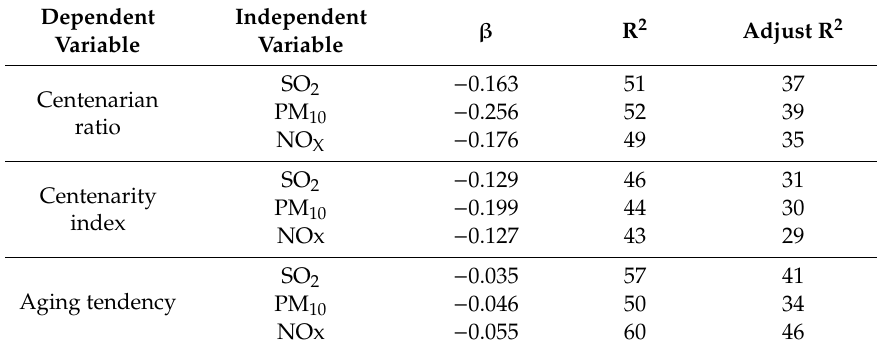
Table 3. Summary of the GWR model of longevity indicators and air